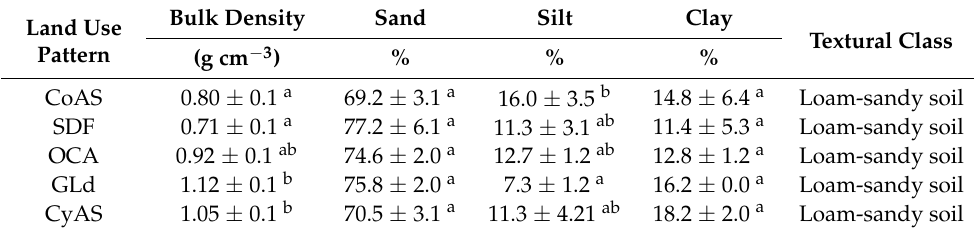
Table 2. Average values of physical properties of the soil for the different L-UCH classes, including their standard deviations (15 repetitions for each L-UCH class). The different letters mean significant difference ( p < 0.05, HSD Tukey).